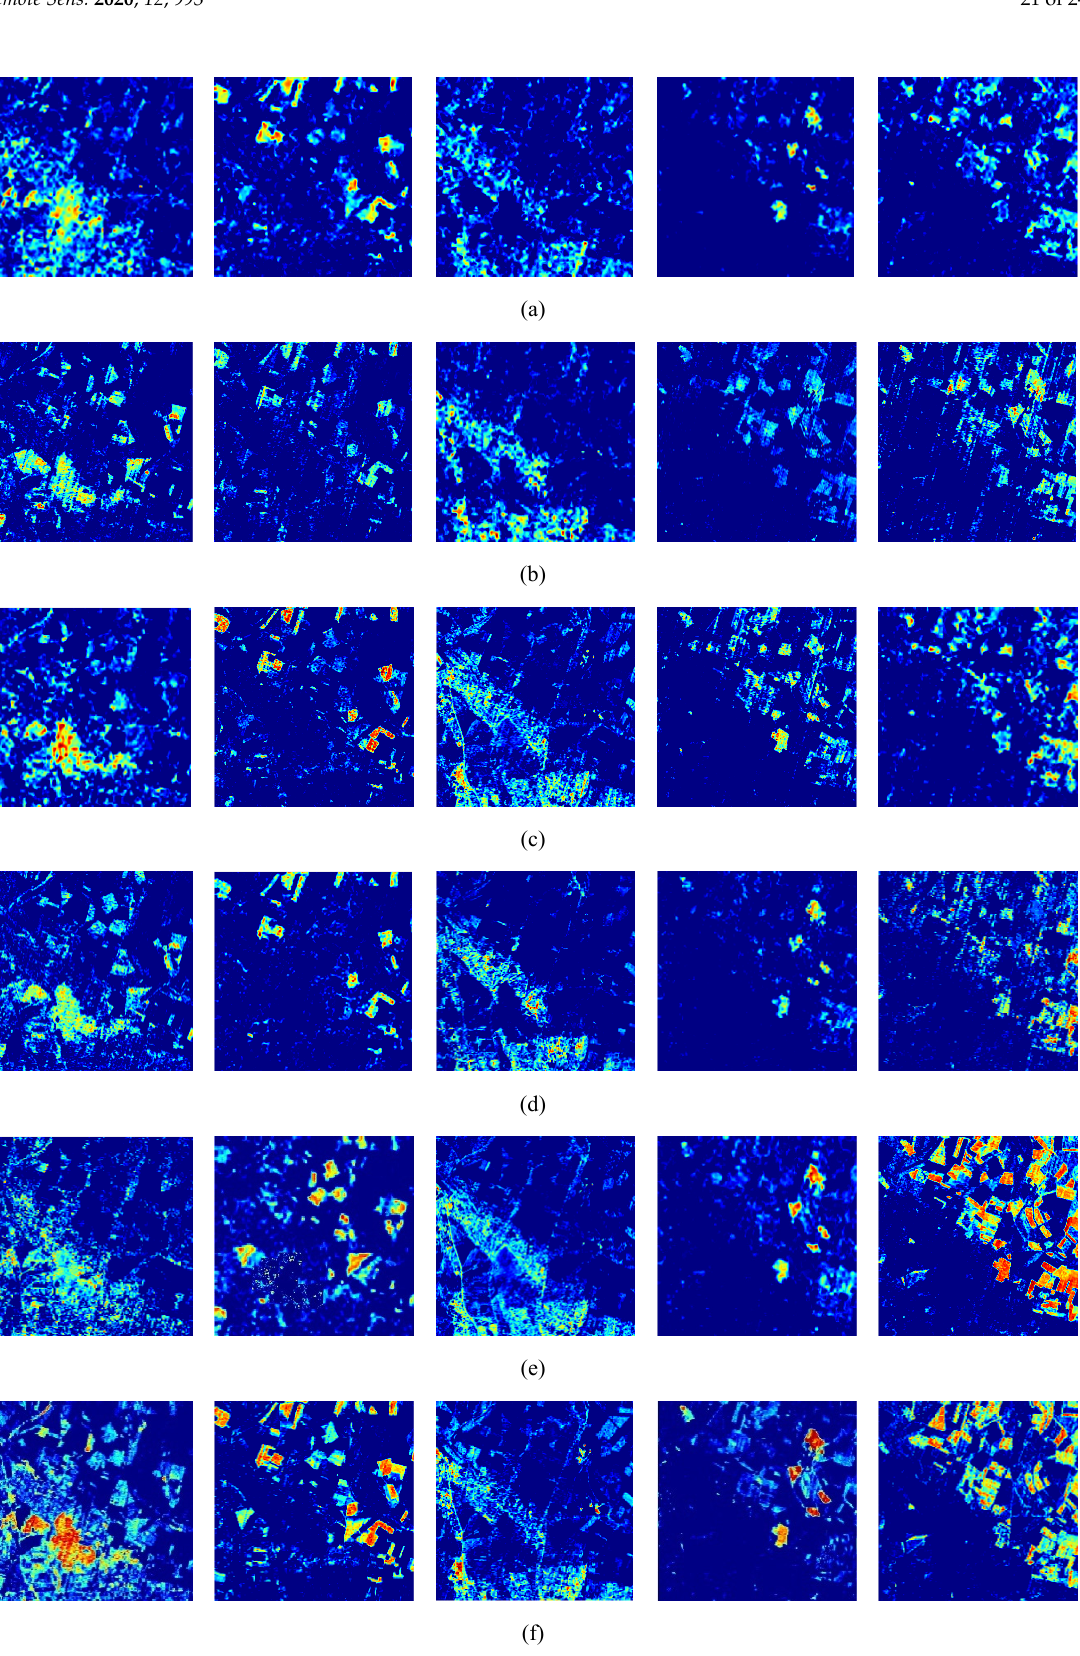
Figure 14. Comparison of abundance maps of the five selected endmembers in real dataset, ( a ) Original HSI, ( b ) Indusion + Arad, ( c ) Indusion + SREM, ( d ) SparseFI + Arad, ( e ) SparseFI + SREM, and ( f ) Our method.